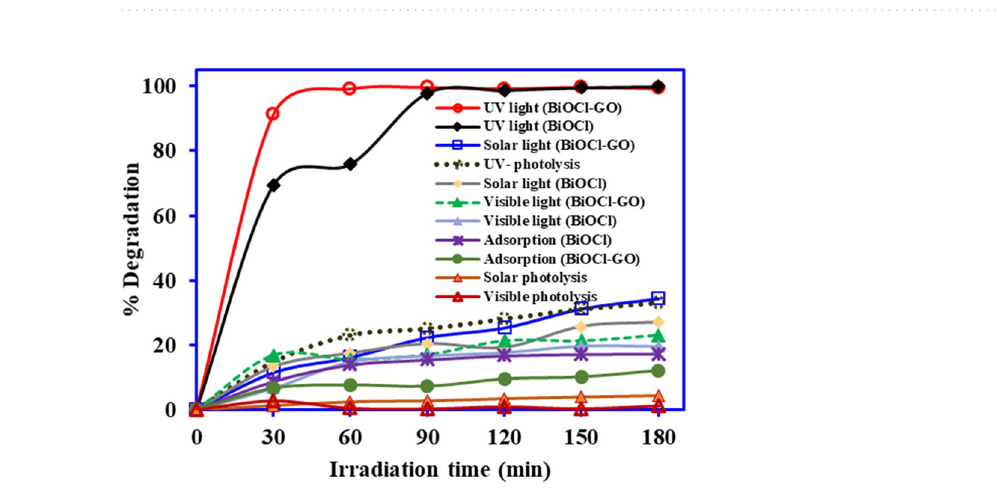
Figure 5. Comparative adsorption, photolysis and photocatalytic degradation of DCF on BiOCl and BiOCl-GO (catalyst mass—1 g L −1 , DCF conc.—25 mg L −1 , vol.—100 mL)